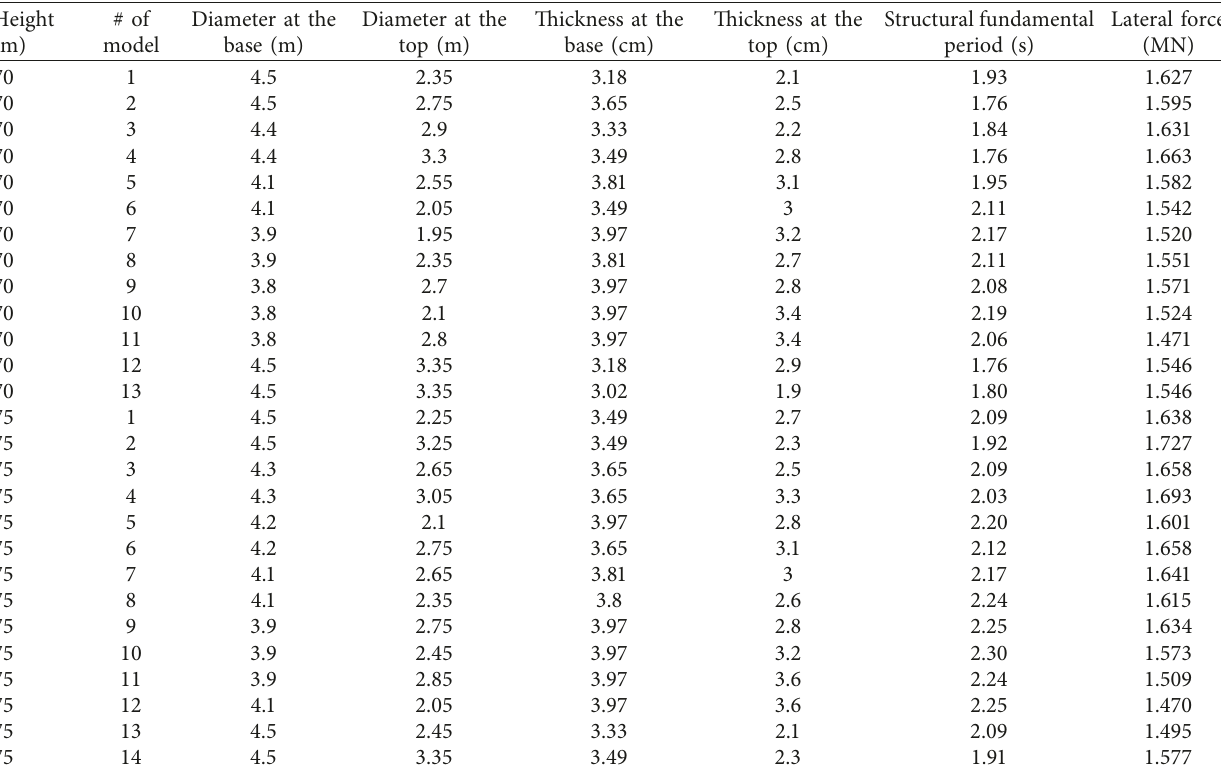
Figure 13: Comparison of results for the structural reliability index. Table 11: Characteristics of the models used in the database.